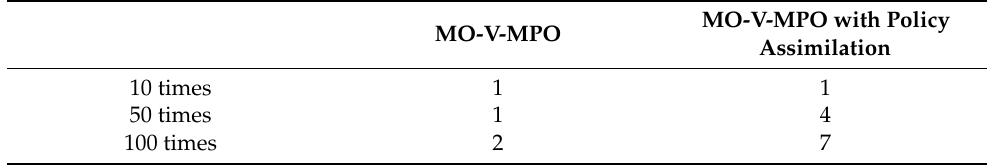
Table 2. Comparison on the number of agents that reached the contact